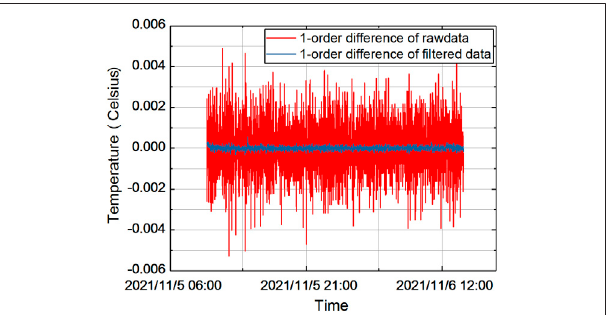
FIGURE 10 | In fl uence of the self-heating effect of the sensor on the measured temperature value.